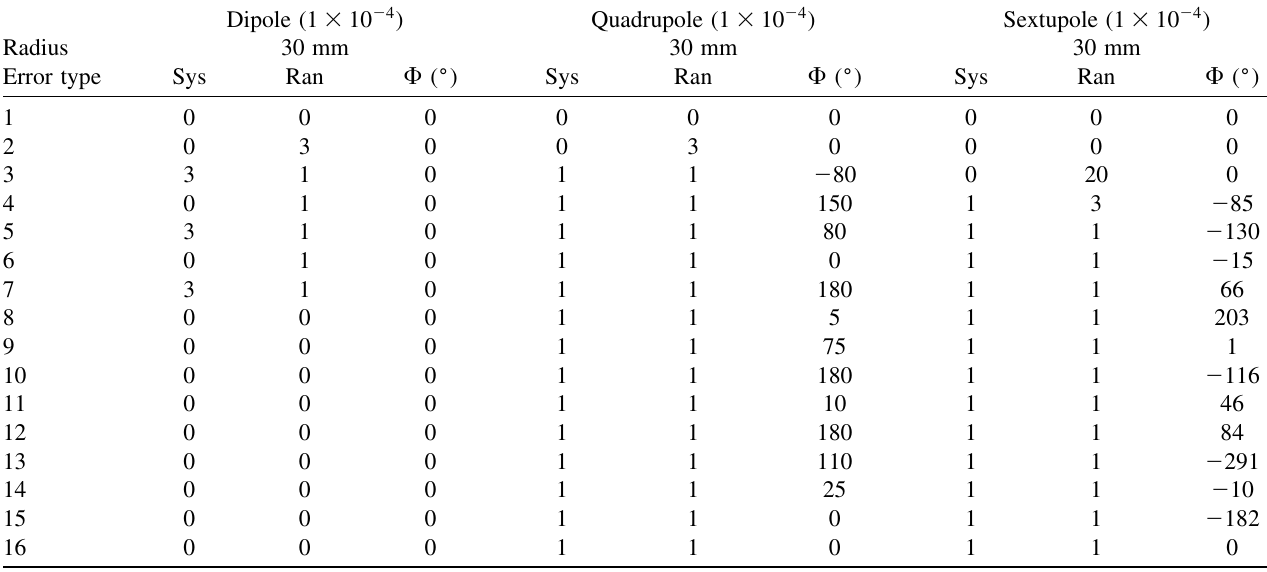
TABLE III. The high-order magnet errors (Sys stands for systematic errors, Ran stands for random errors, and (cid:2) is the angle). Dipole ( 1 (cid:1) 10 (cid:2) 4 ) Quadrupole ( 1 (cid:1) 10 (cid:2) 4